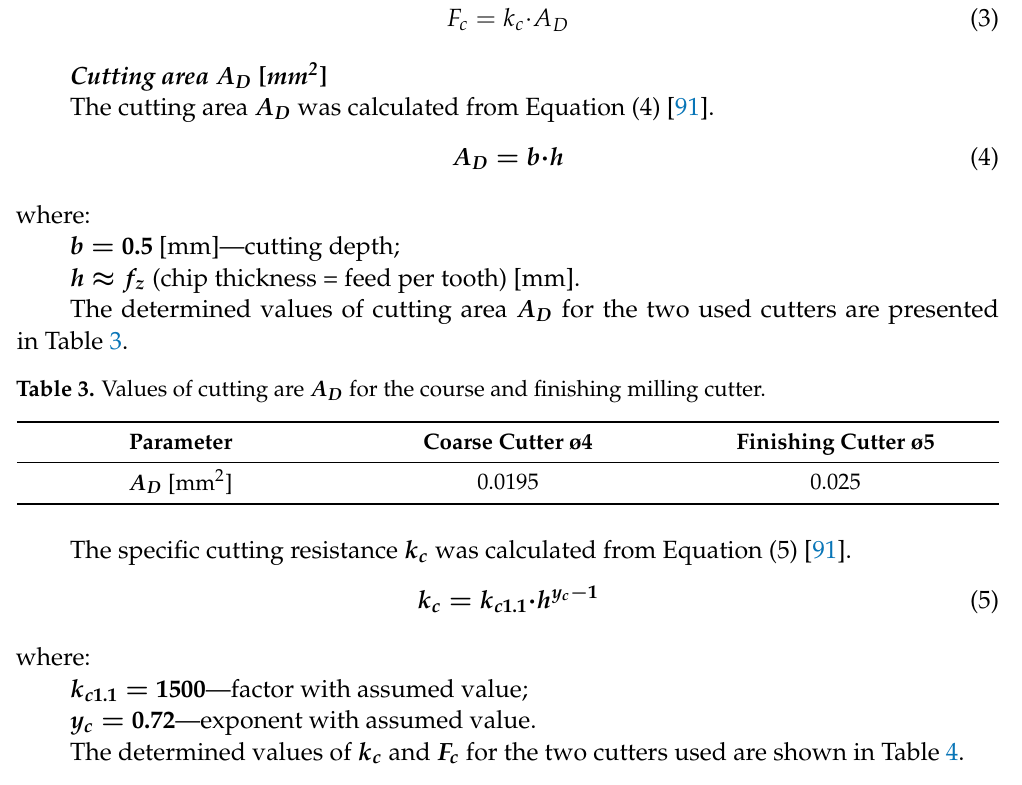
Table 4. The determined values of k c and F c for the two cutters used.